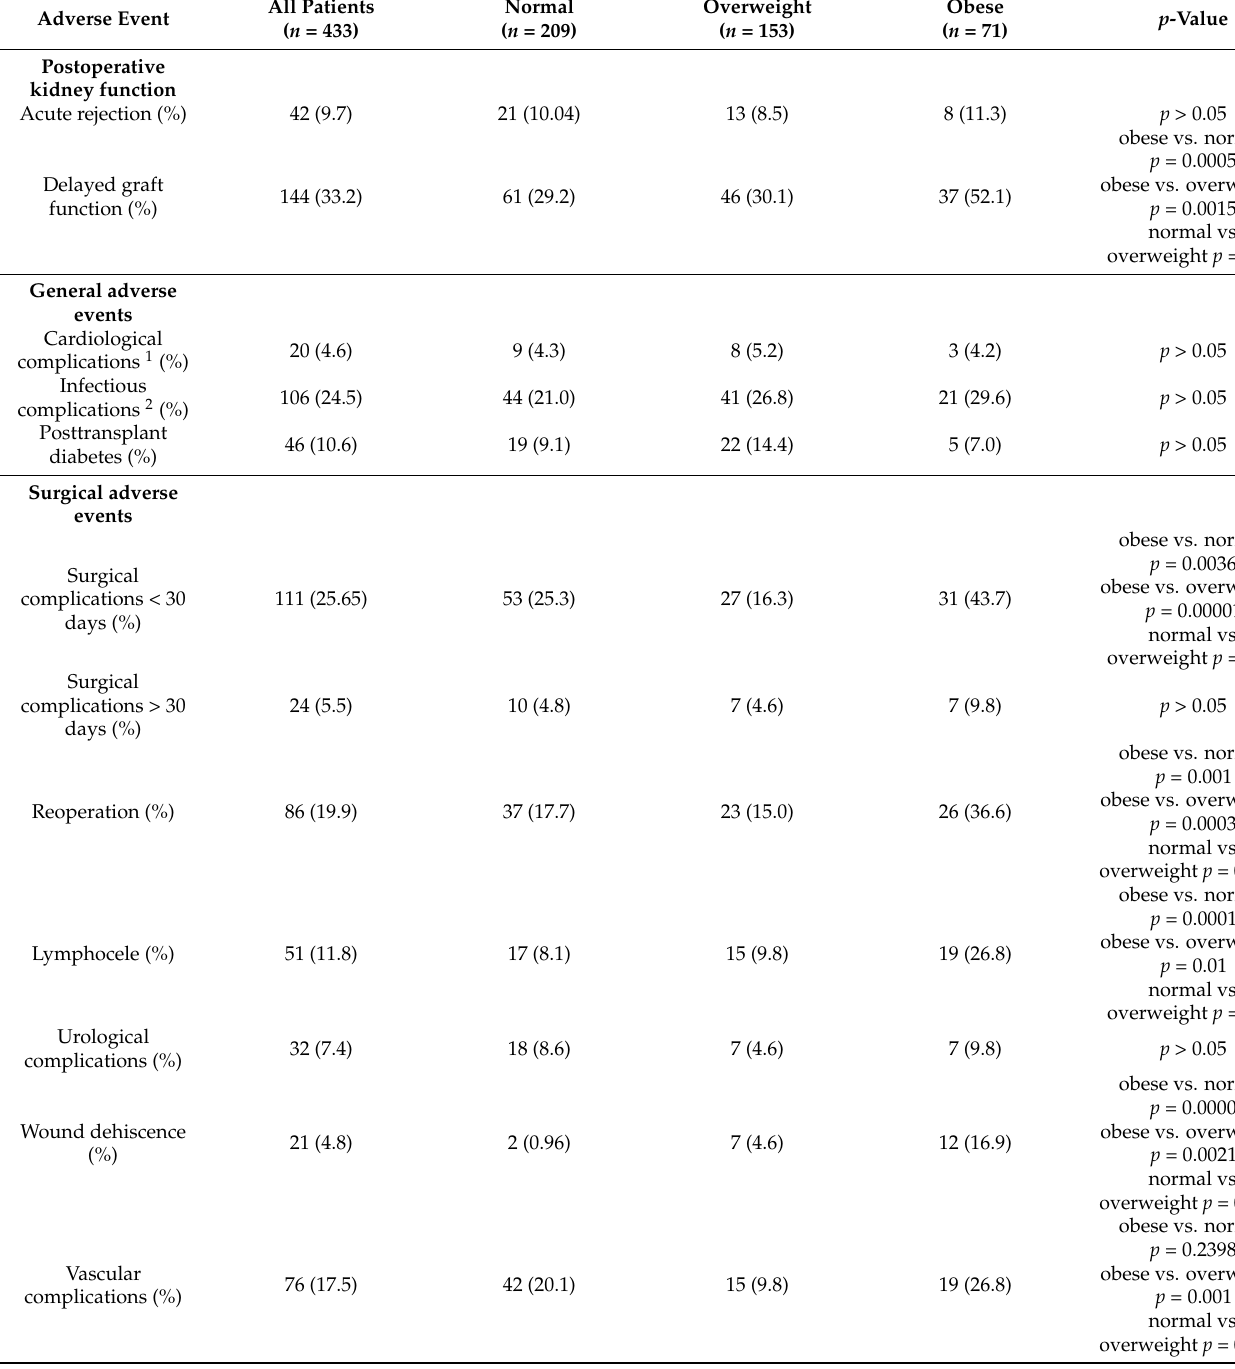
Table 2. Postoperative adverse events of kidney transplantation stratified by type and BMI ( p < 0.05 statistically significant).